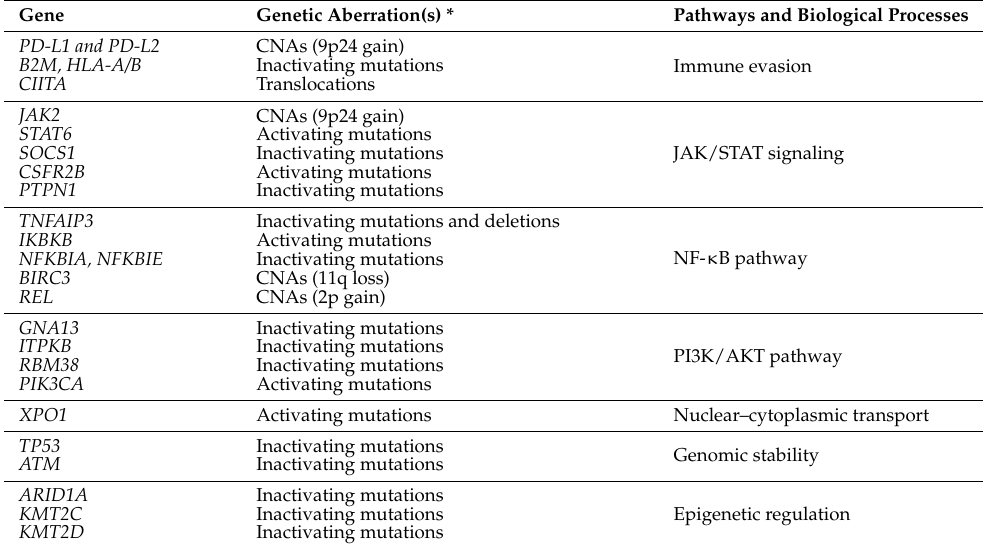
* Activating mutations target oncogenes, while inactivating mutations target tumor suppressor